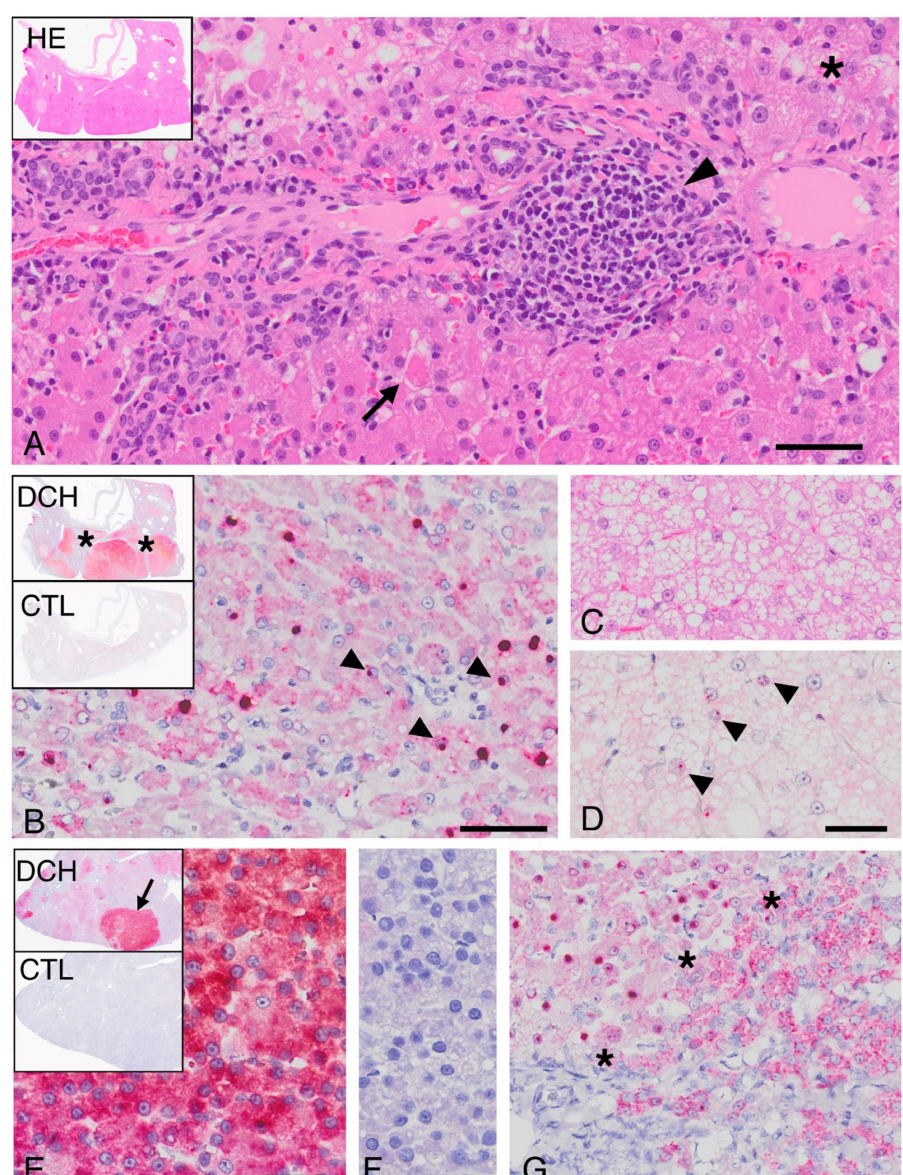
Figure 2. DCH associated chronic hepatitis ( A – D ) and DCH-associated hepatocellular carcinoma ( E – G ). ( A )Lymphocytesarepresentclusterednearportaltracts(arrowhead)andwithinsinusoids. Scattered, variably sized groups of hepatocytes are vacuolated (asterisk). An individual hepatocyte (arrow) is hypereosinophilic and individualized (necrosis). Inset, overview, medial lobe. Hematoxylin and eosin, Bar = 50 microns. ( B ) Chronic hepatitis, in situ hybridization. Inset, in this low magnification overview there is DCH probe hybridization (red) in the vast majority of the section. Collapsed lobules and fibrous tracts fail to hybridize (asterisks). DCH ISH demonstrates a combination of nuclear (arrowheads) and cytoplasmic hybridization, ISH, Bar = 50 microns. ( C ) There are scattered regions of vacuolar degeneration. Hematoxylin and eosin. ( D ) In a serial section, probe hybridization is limited to eccentric “dots” within nuclei. ISH. Bar = 50 microns. ( E ) DCH-associated HCC using an ISH probe for DCH at low magnification (inset, top) demonstrates the nodular HCC region with intense cytoplasmic hybridization (arrow) that is viewed by higher magnification in the larger panel. Bar = 50 microns. Using a control probe, no hybridization is present on a serial section of the same nodule (inset, bottom) and ( F ). ( G ) In other regions of the tumor there is more variability in probe hybridization. The asterisks define the border of hepatocytes with both nuclear and cytoplasmic hybridization (left) directly abutting hepatocytes where detectable hybridization was limited to the cytoplasm